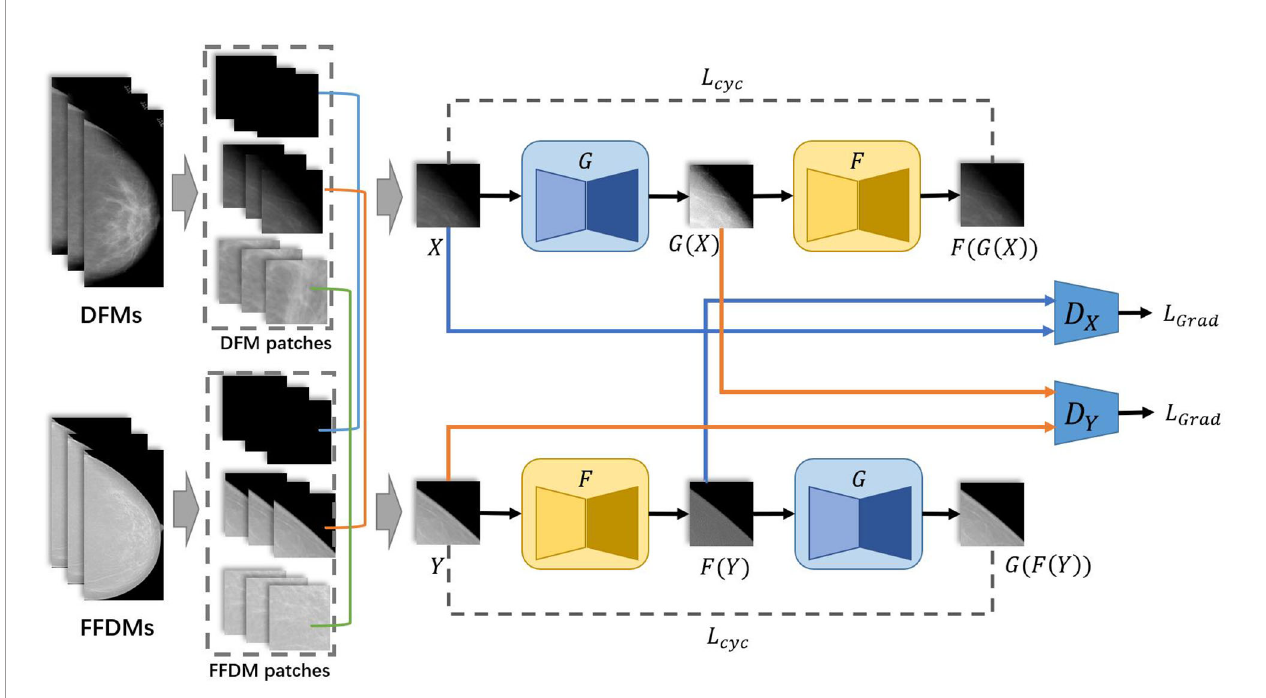
FIGURE 1 | Overall architecture of